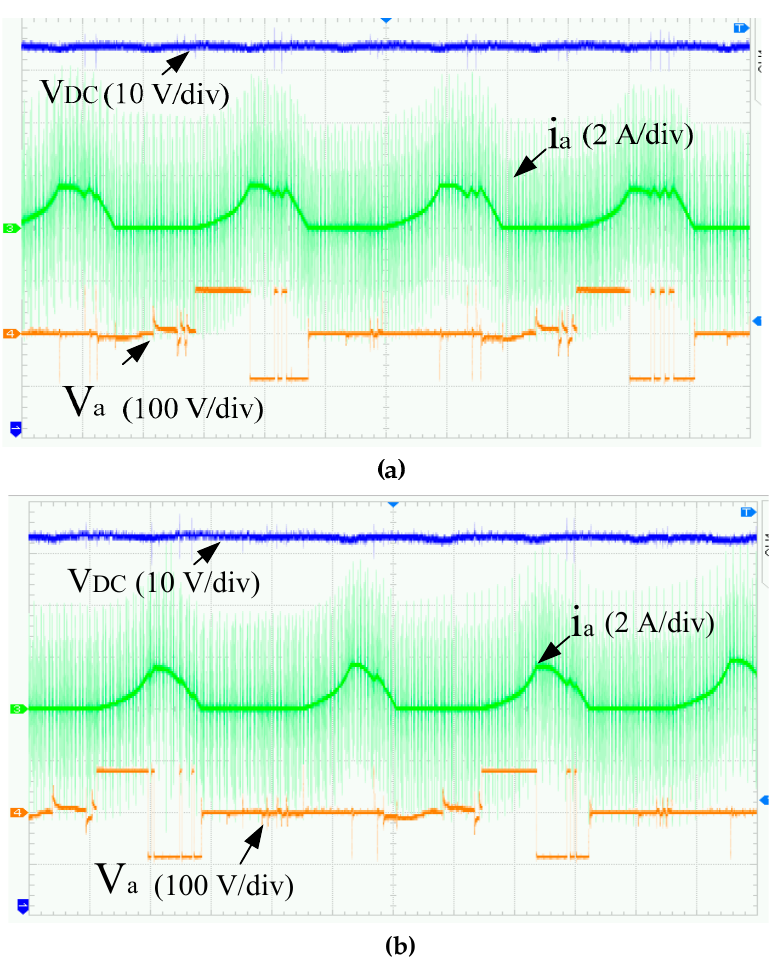
Figure 15. Experimental waveforms at 500 rpm of two controllers of SRG power system: ( a ) PI control; ( b ) PR control.